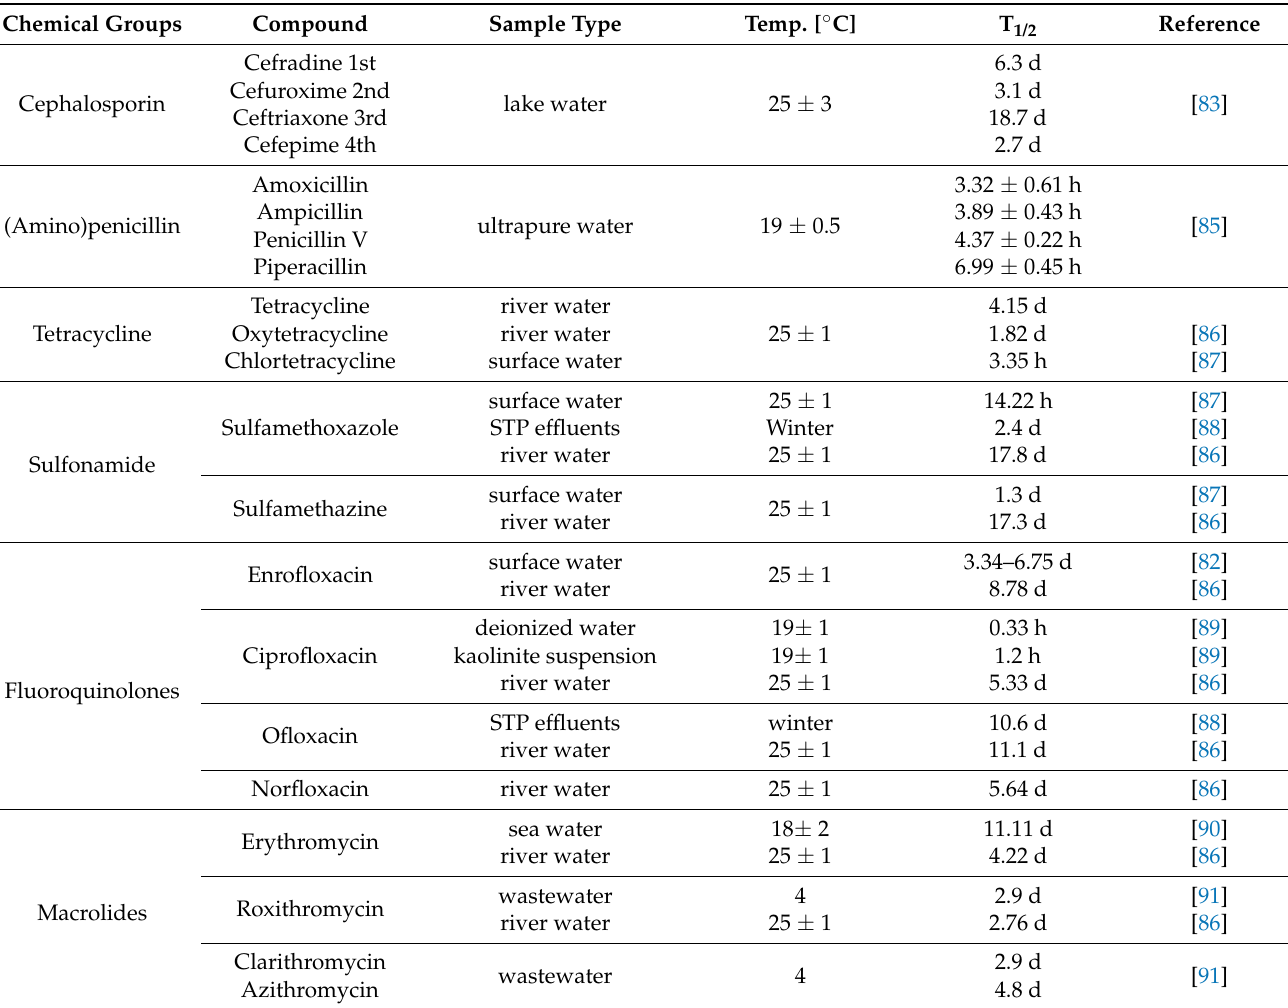
Table 2. Half-lives (T 1/2 ) in days (d) or hours (h) of antibiotics in different water samples under aerobic conditions and